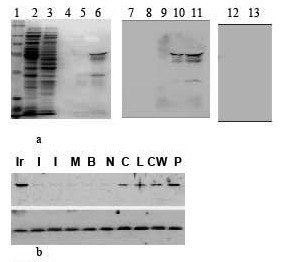
a (Lanes 1–6) SDS PAGE of (lane 1) mwt markers; (lane 2) crude bacterial cell lysate containing the GST-RPS2 fusion protein; (lanes 3–4) unbound proteins; (lanes 5–6) GST-RPS2 fusion protein bound to the MagneGST Glutathione Particles; (lanes 7–11) RPS2 antibody (1:1000 dil.) Western blots of proteins in lane 2, 3, 4, 5, and 6, respectively. (lanes 12–13) Western blots of fractions in lanes 5–6 following preabsorption of the P1 antibodies (1:200 dil.) with excess recombinant RPS2 (200 ng). Note: the P1 antibodies blotted 2 different bands of the GST-RPS2 complex at ~62 Kda plus the 33 Kda RPS2 protein. 1b. Western blots with RPS2 antibodies (1:1000 dil.) of nuclear protein extracts from: (Ir) pBABE-IBC-10a-c-myc; (I) 2 different IBC-10a sub-clones; (M) mouse NIH-3T3; (B) BPH-1, (N) NPTX-1532, (C) CPTX-1532, (L) LNCaP, (CW) CRW22R1, and (P) PC-3ML cells. Lower bands: actin antibody blots of nuclear extracts. Loaded at 20 ug/lane.